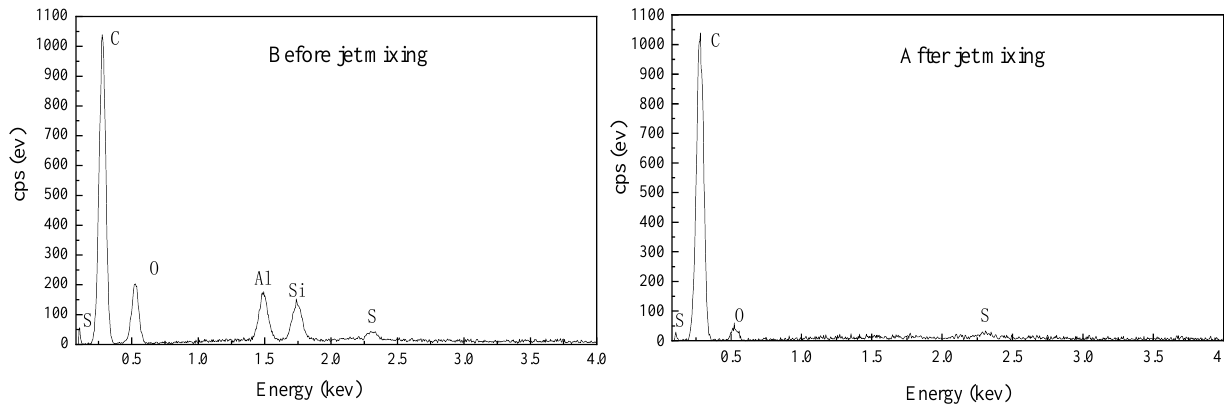
Figure 5. SEM morphology diagram of artificially mixed coal sample before and after jet mixing. ( a ) Before jet mixing; ( b ) After jet mixing.